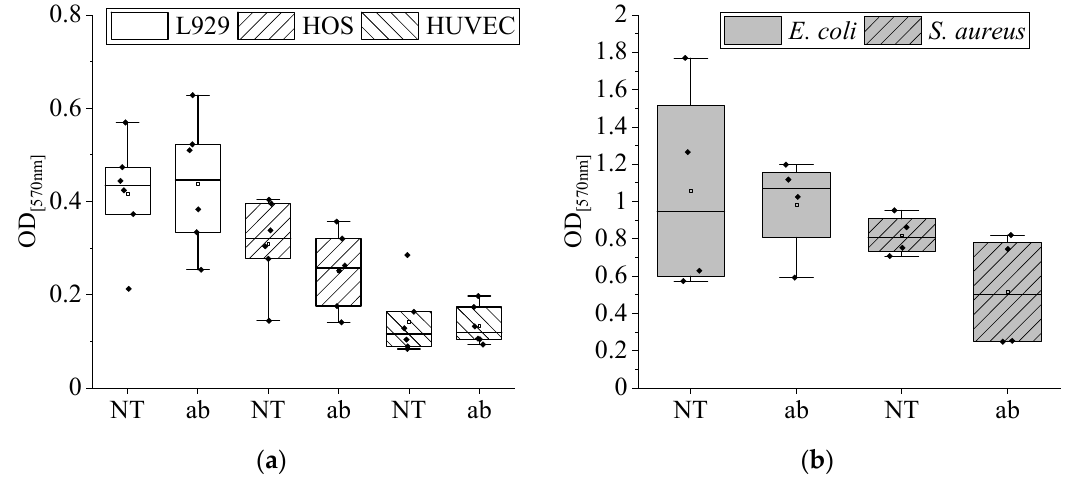
Figure 9. ( a ) Effects of different surfaces on the proliferation of L929, HOS and HUVEC cells after 72 h incubation, and ( b ) bacterial proliferation of E. coli and S. aureus after 24 h incubation; OD = optical density at 570 nm; n = 4–6.